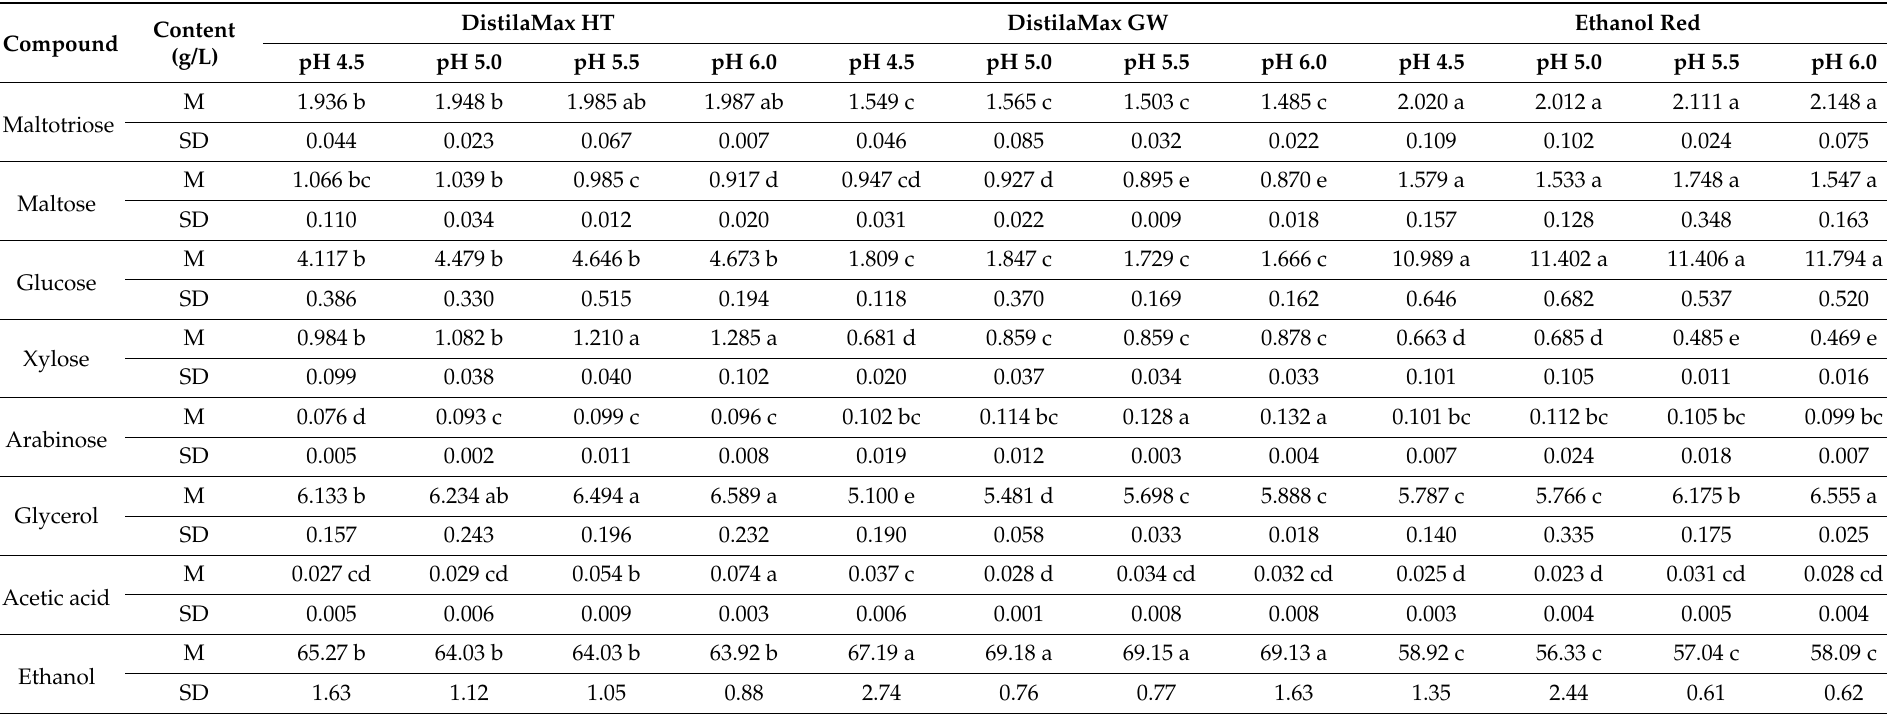
Table 3. Chemical composition of mashes prepared by the pressureless starch liberation method and fermented by various yeast strains.